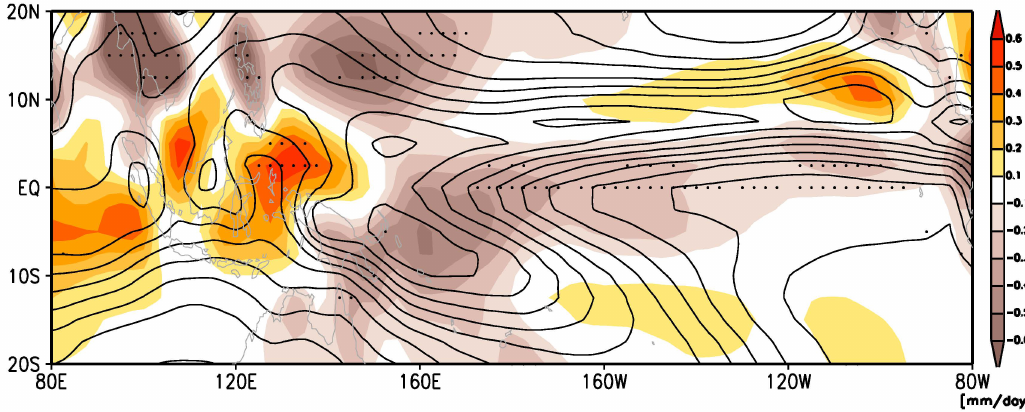
Figure 5. Regression coefficients of climatological mean (1979–2005) precipitation with respect to the one standard deviation westward shift of C W in the 29 models. One standard deviation of C W is 5.9 ˝ and the areas with dots are significant at the 90% confidence level. Contours represent the climatological mean precipitation in the